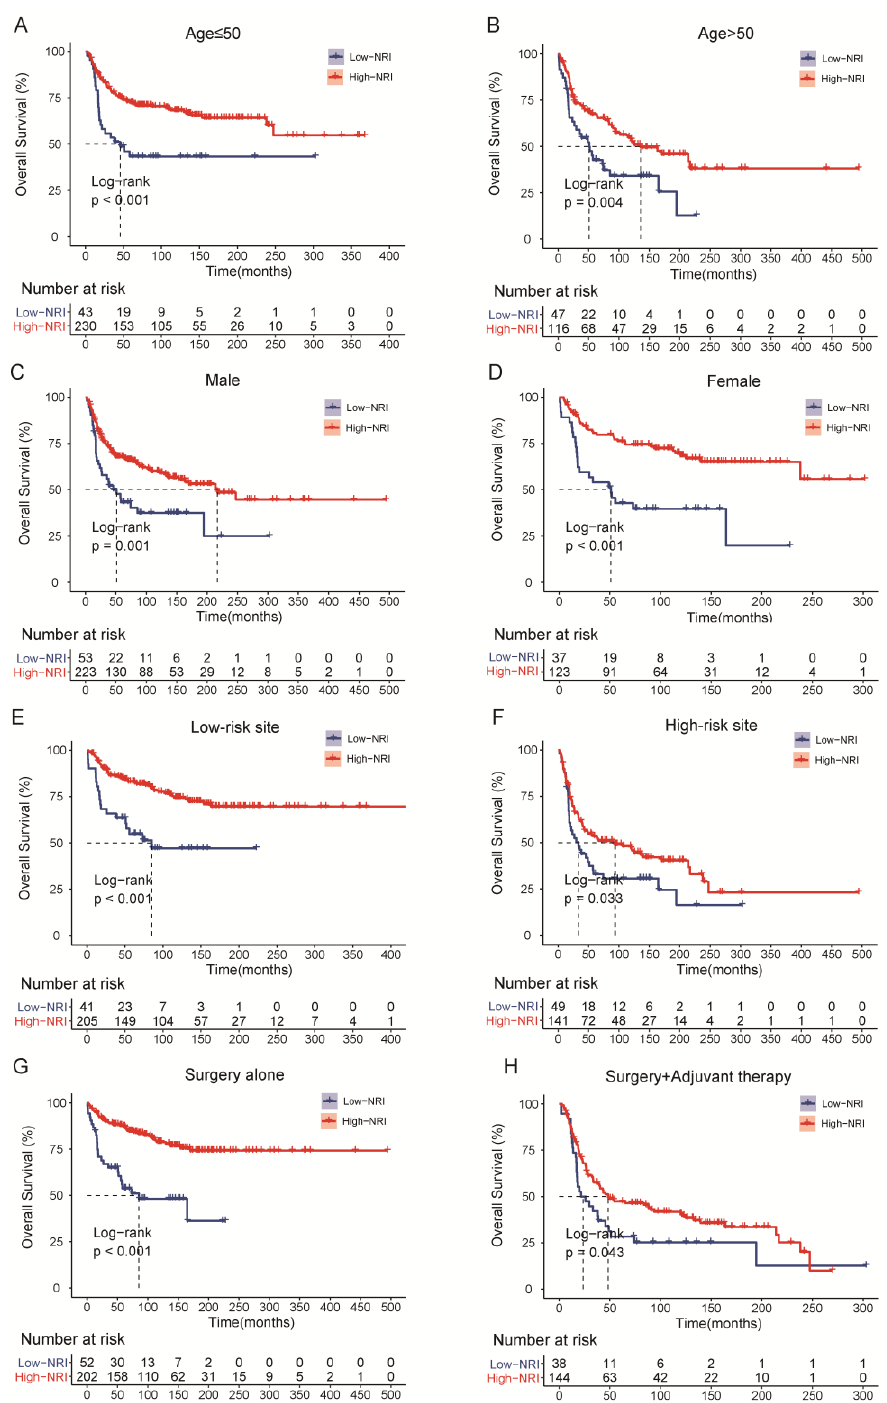
Figure 5. Overall survival (OS) curves of subgroup analysis in HNSTS patients for different types of clinical manifestations according to NRI. ( A ) The OS rate of patients with age ≤ 50; ( B ) The OS rate of patients with age > 50; ( C ) The OS rate of male patients; ( D ) The OS rate of female patients; ( E ) The OS rate of patients with low-risk site; ( F ) The OS rate of patients with high-risk site; ( G ) The OS rate of patients with surgery; ( H ) The OS rate of patients with surgery and adjuvant therapy. NRI: nutritional risk index.